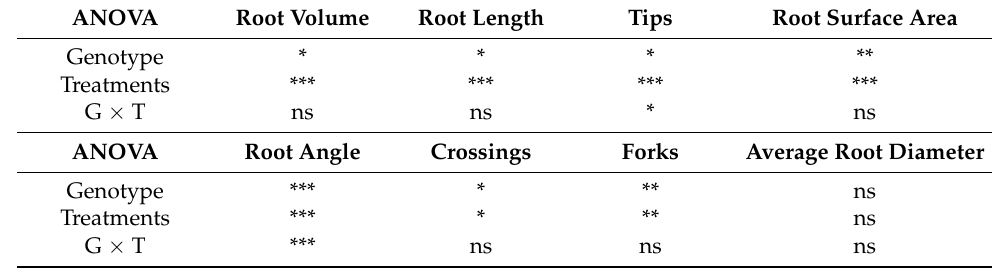
Table 2. Analysis of variance (ANOVA) for root